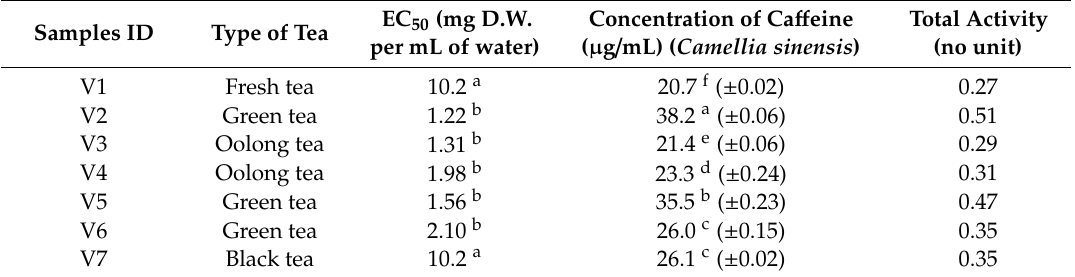
Table 2. Total activity of tea sample allelochemical (ca ff eine) on a plant basis.